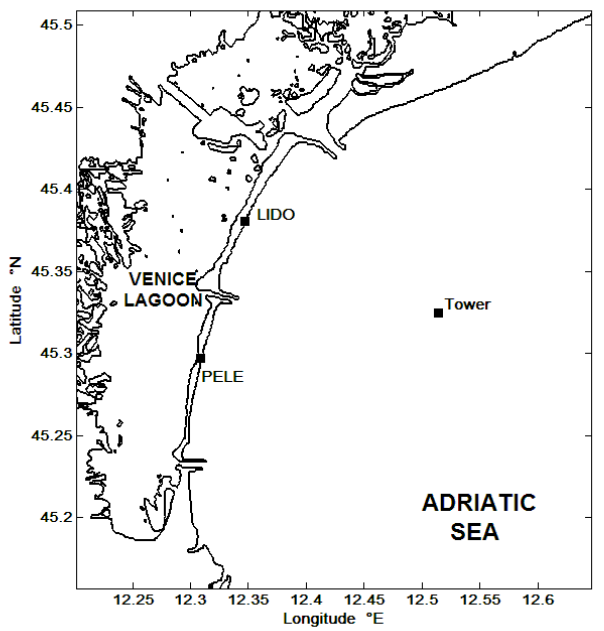
Figure 1. Fig. 1. Study area. Squares denote the locations of two radar sta- tions (Kovaˇcevi´c et al., 2004) and the location of the oceanographic Tower where the bottom-mounted ADCP was